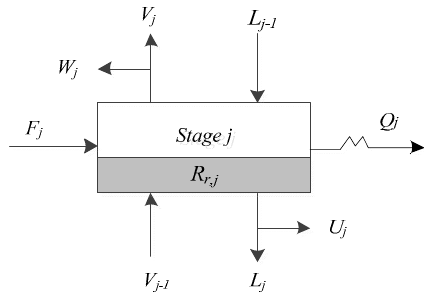
Figure 2. The jth equilibrium stage of the reactive distillation column.